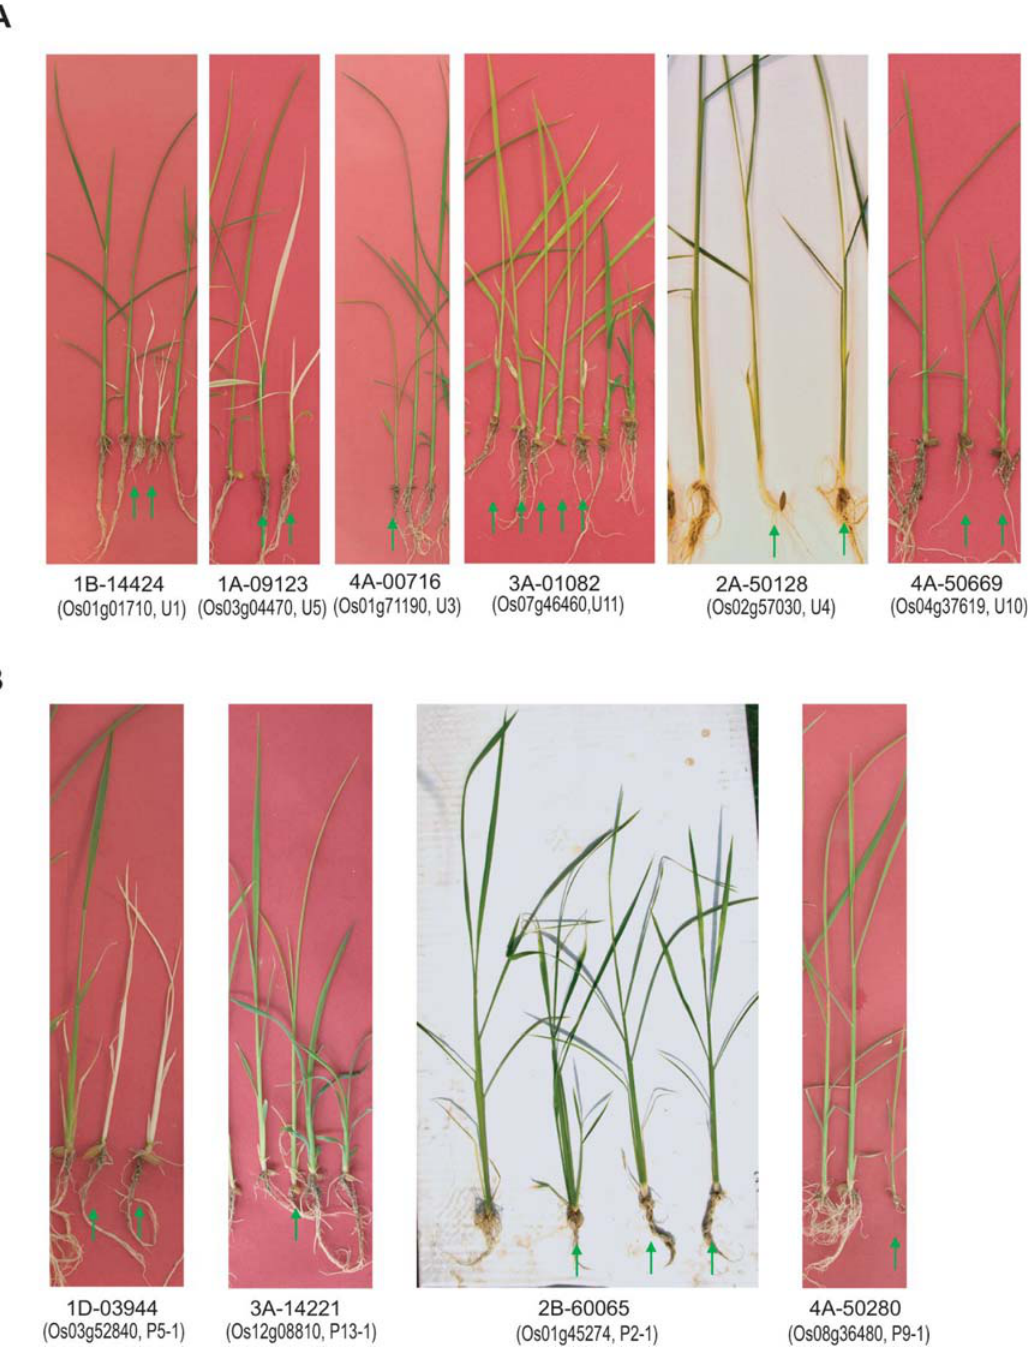
Figure 3. Functional Analyses of Unique Genes and Gene Family Members Predominantly Expressed in the Light by Using T-DNA Insertional Mutants. (A) Co-segregating phenotypes observed in knockout lines affecting 6 unique genes. (B) Co-segregating phenotypes observed in knockout lines affecting 4 gene family members predominantly expressed in the light. Green arrows indicate mutant phenotypes that co- segregated with T-DNA insertions in the candidate gene (gene designations are given in parentheses). All primers used for genotyping are described in Table S5. The phenotype analyses for 20 light-inducible genes are detailed in Table 8.